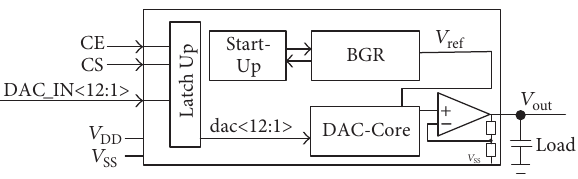
Figure 1: Block diagram of the proposed DAC circuit.